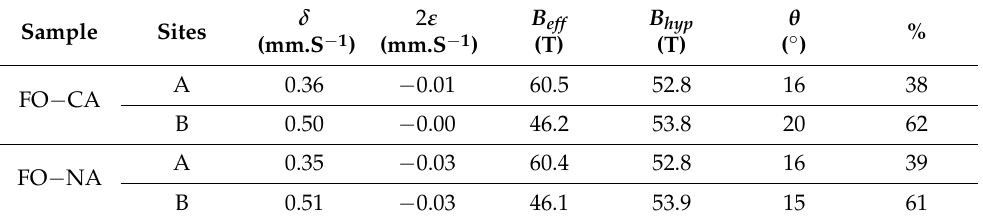
Figure 2. 57 Fe Mössbauer spectra measured at 12 K under high magnetic field (8 T) and fitted with 2 sextets corresponding to iron in A − site, and B − site (fitted using a Lorentzian lines) for ( a ) FO − CA and ( b ) FO − NA. Table 2. Summary of obtained values. of hyperfine parameters (Isomer Shift, Quadrupolar Shift, Effective and Hyperfine fields, Angle θ , and weight) obtained at 12 K under external field of 8T. Sample